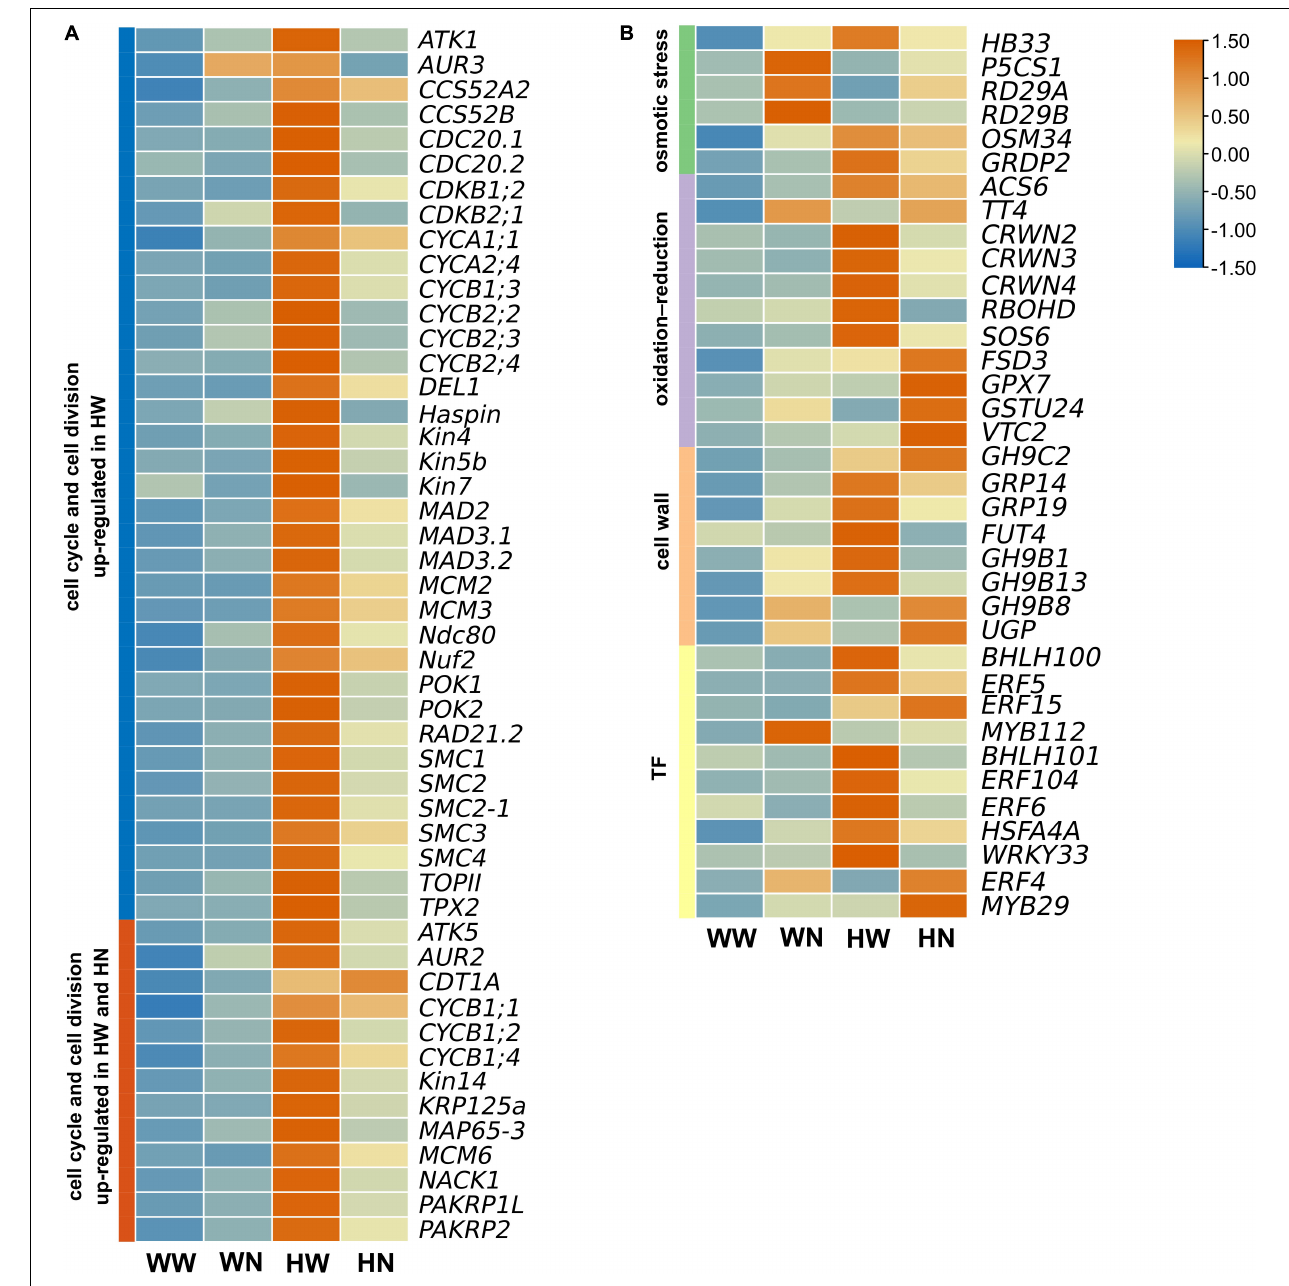
FIGURE 4 | The expression patterns of selected differentially expressed genes (DEGs) represented as a heatmap. (A) Up-regulated DEGs related to the cell cycle and cell division only in HW vs. WW, or both in HW vs. WW and HN vs. WW. (B) Up-regulated DEGs related to salt stress only or both in HW vs. WW and HN vs. WW. Among osmotic stress responsive genes, HB33 was up-regulated in HW vs. WW; P5CS1 , RD29A , and RD29B were up-regulated in HN vs. WW. BGLU6 and GRDP2 were significantly up-regulated in HW vs. WW and HN vs. WW; Of DEGs involved in oxidation–reduction processes, ACS6 and TT4 were significantly up-regulated in HW vs. WW and HN vs. WW; CRWN2 , CRWN3 , CRWN4 , RBOHD , and SOS6 were up-regulated in HW vs. WW; FSD3 , GSTU24 , and VTC2 were up-regulated in HN vs. WW; Among genes related to cell wall organization, GH9C3 and GRP14 were significantly up-regulated in HW vs. WW and HN vs. WW; GRP19 , FUT4 , GH9B1 , and GH9B13 were up-regulated in HW vs. WW; and GH9B8 and UGP1 were up-regulated in HN vs. WW; Of genes related to the transcription factors, BHLH100 , ERF5 , ERF15 , and WRKY38 were significantly up-regulated in HW vs. WW and HN vs. WW; BHLH101 , ERF104 , ERF6 , HSFA4A , and WRKY33 were up-regulated in HW vs. WW; and ERF4 and MYB29 were up-regulated in HN vs. WW. WW, pretreated with water and not salt-stressed; WN, pretreated with water and salt-stressed; HW, pretreated with H 2 O 2 and not salt-stressed; HN, pretreated with H 2 O 2 and salt-stressed. Heat map diagram of the log2FC, the red and blue colors specify up-and down-regulated expressions.